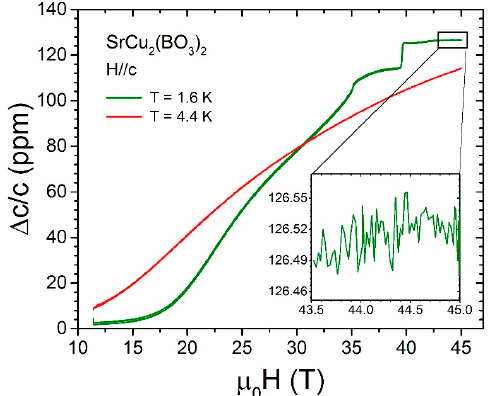
Figure 5. Axial magnetostriction along the crystallographic c -axis ( ∆ c/c ) in the frustrated quantum magnet SrCu 2 (BO 3 ) 2 measured to 45 T at 1.6 K and 5.3 K taken with the Hyperion ® model si155 interrogator by Micron Optics in a continuous 45 T hybrid magnet at the National High Magnetic Field Laboratory (NHMFL). For these measurements, a 2 mm-long FBG manufactured by Technica SA was used. The magnetostriction plateaus observed at 35 T and 39.65 T correspond to magnetization plateaus observed at relative magnetization M/Ms = 1/4 and 1/3, respectively. The strain sensitivity achieved in this measurement is approximately 2 × 10 − 8 [30].